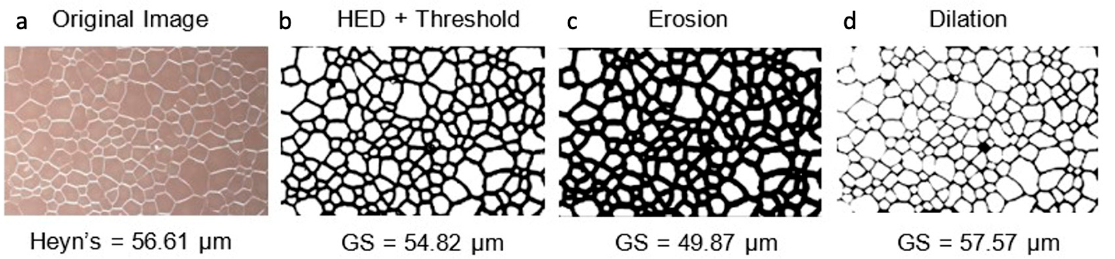
Figure 2. Optical micrograph ( a ) after HED and initial thresholding ( b ), 8 iterations of erosion ( c ), and 8 iterations of dilation ( d ). The values underneath indicate the measured grain size (GS) of the contours using the mean grain diameter determination method outlined below.